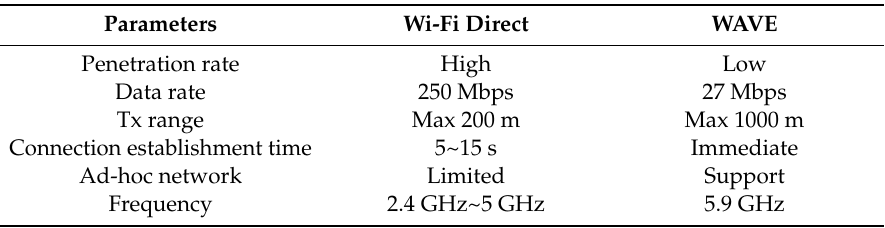
Table 1. Comparison between Wi-Fi Direct and